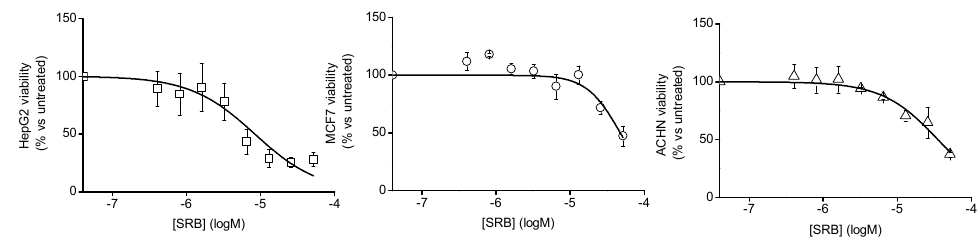
Figure 6. Viability of different cancer cell lines as a function of the concentration of free SRB. On the basis of these findings, we chose to test the activity of the PolyCDNO/SRB under visible light excitation and, for comparison, in the dark using a concentration of the drug of 1.5 µ g mL − 1 , which was well below the IC 50 for all the cell lines tested, and an irradiation time of 40 min, which allowed to generate a moderately cytotoxic NO dose. The overall results are reported in Figure 7.